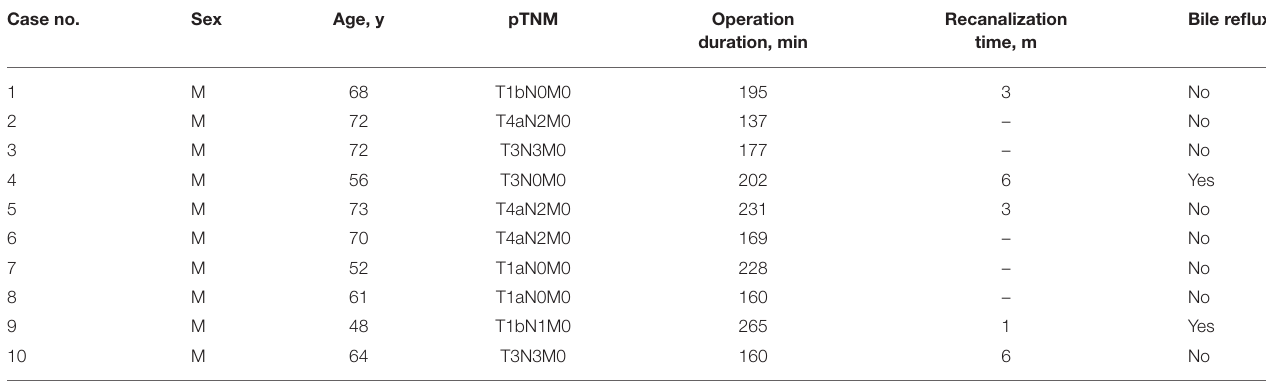
TABLE 1 | Details of the 10 patients who had undergone uncut Roux-en-Y. Case